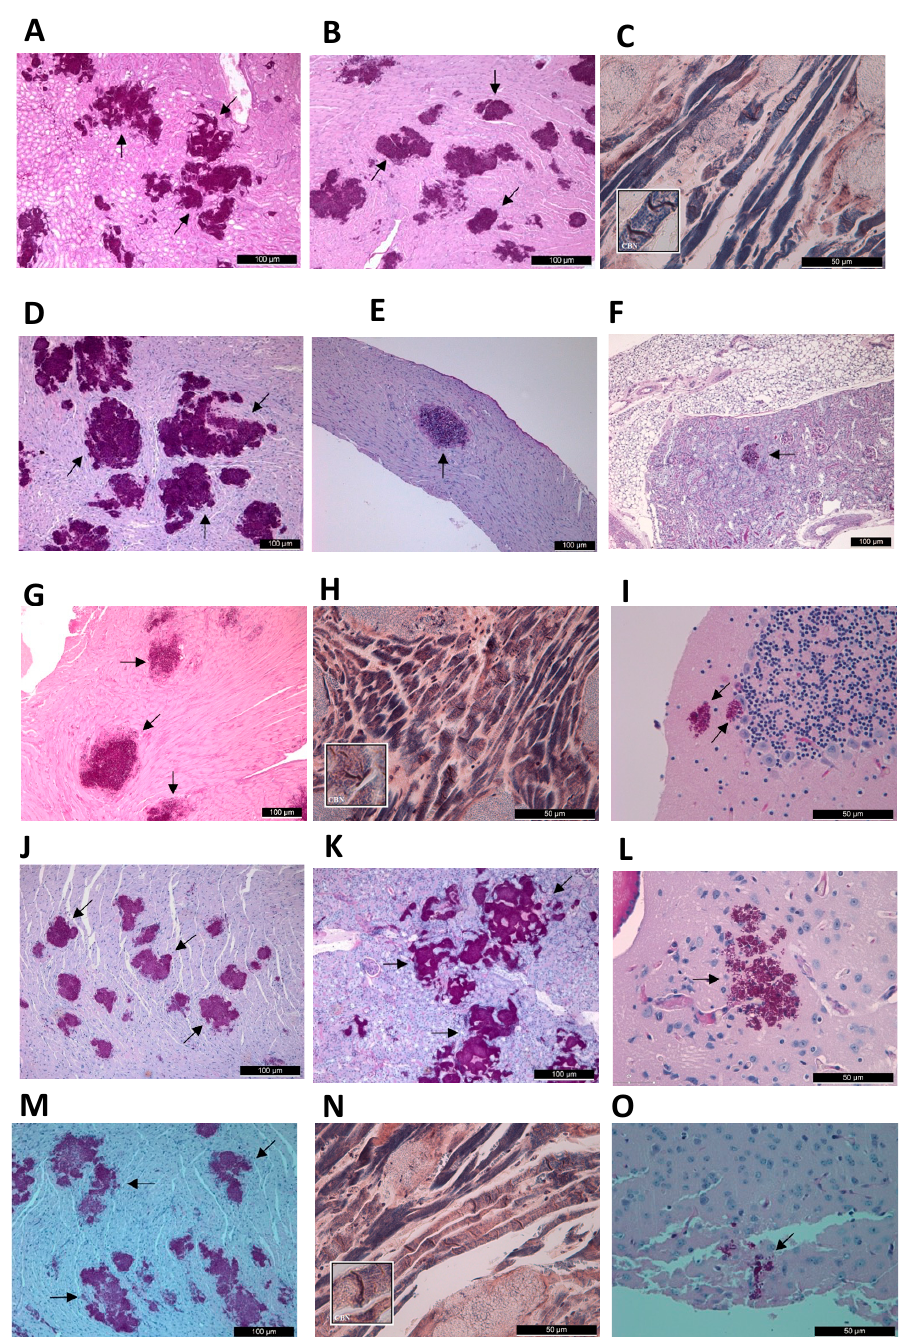
Figure 4. Histopathological examination of the heart, kidney and brain with Periodic Acid Schiff or Mallory’s PTAH staining from amphotericin B (AMB) treated mice found dead after intravenously challenged with Candida auris isolates. In mice infected with isolate 196 (South Asian clade) which died on day 5, kidneys ( A ) showed large multifocal fungal lesions, fungal cells were detected in the parenchyma, necrosis occurred in the tubular tissue, but glomeruli were not invaded. In the heart ( B ), C. auris produced large aggregates and coagulative necrosis of myocytes. Mallory’s PTAH staining always revealed contraction band necrosis (myofibrillar degeneration) ( C ). In the case of mice infected with isolate 12,372 (East Asian clade) which died on day 6, in the hearts multifocal ( D ) or only focal ( E ) fungal infiltrates were found. In the kidneys ( F ) small lesions were detectable (black arrow). In mice infected with isolate 204 (South African clade) which died on day 5, 4–5 ag- gregates were seen in the hearts ( G ) with contraction band necrosis ( H ). In the cerebellum ( I ), one large and one smaller PAS positive fungal lesions were seen. In mice infected with isolate I-156 (South American clade) which died on day 5, multifocal, large aggregates were seen in the hearts ( J ) and kidneys ( K ) with abundant yeast cells in the cerebrum ( L ). In mice infected with isolate CDC B-13108 which died on day 4, the heart showed large and small multifocal infiltrates ( M ) with contraction band necrosis ( N ). In the cerebrum ( O ), yeast cells were visible. Fungal lesions were indicated with black arrows. Magnification, ( A , B , D – G , J , K,M ) ×100, ( C , H , I , L , N,O ) ×400.